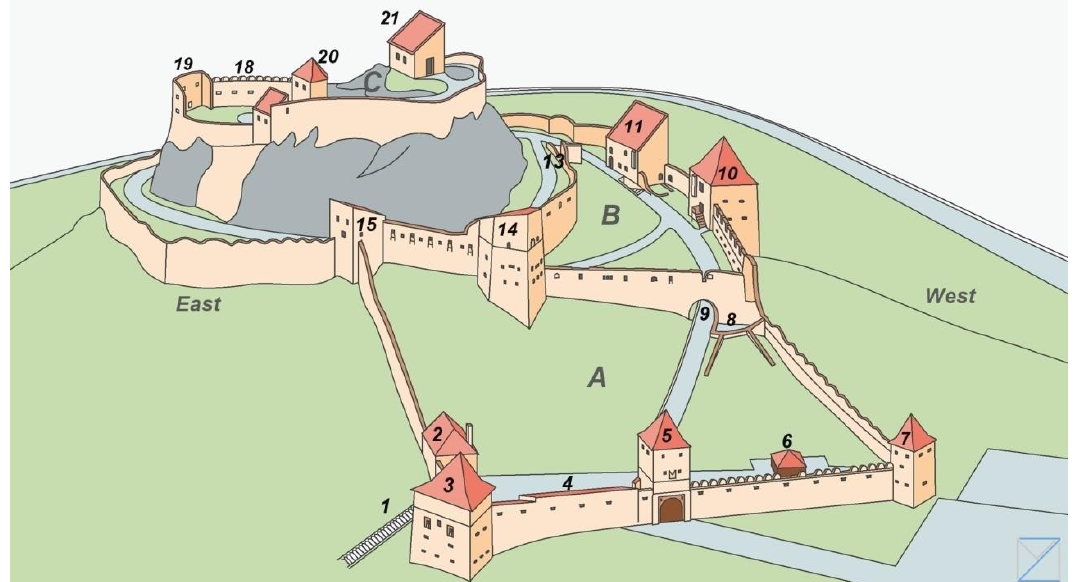
Figure 3: Bird’s-eye view drawing of Rupea Fortress in its current form (north side) Drawing by MAROȘI Zoltan,